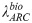
Trajectories of sensitivities.Solid red line: trajectory for λARCbio and λARCetoh with inhibition. Solid black line: trayectories without inhibition. Dashed blue line: inhibition starting time. Dashed black line: zero coordinate in Y axis. (a) λARCbio for kLa = 25 h−1. (b) λARCbio for kLa = 15 h−1. (c) λARCetoh for kLa = 25 h−1. (d) λARCetoh for kLa = 15 h−1.